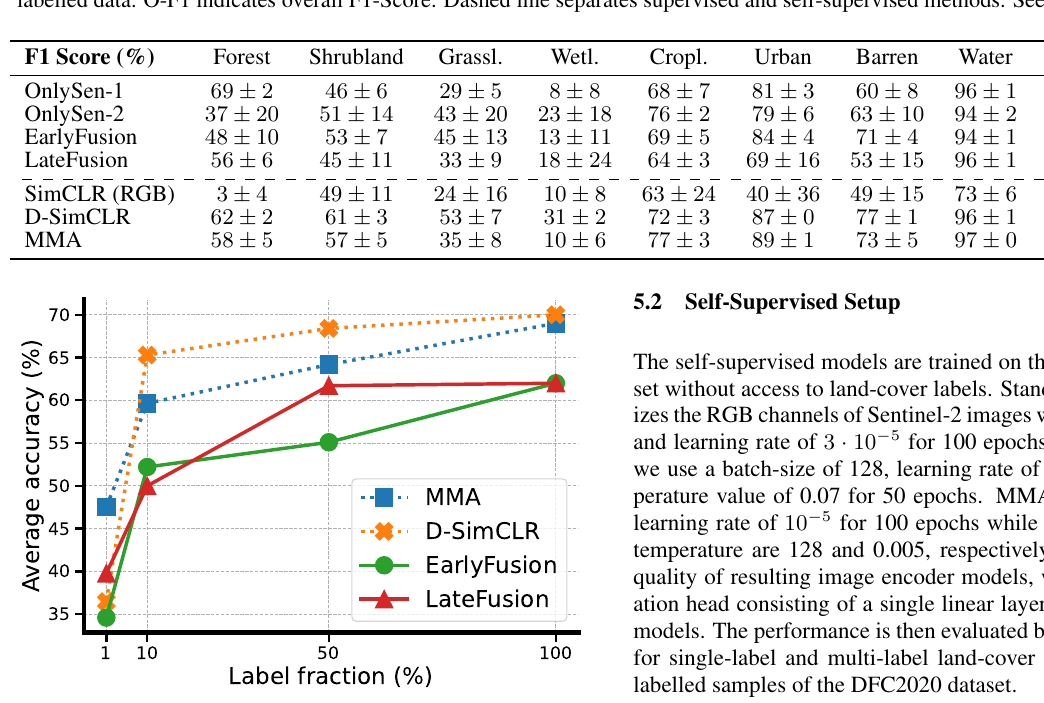
Figure 4. Average accuracy at different label fractions for supervised EarlyFusion/LateFusion, and fine-tuned self-supervised D-SimCLR/MMA methods.